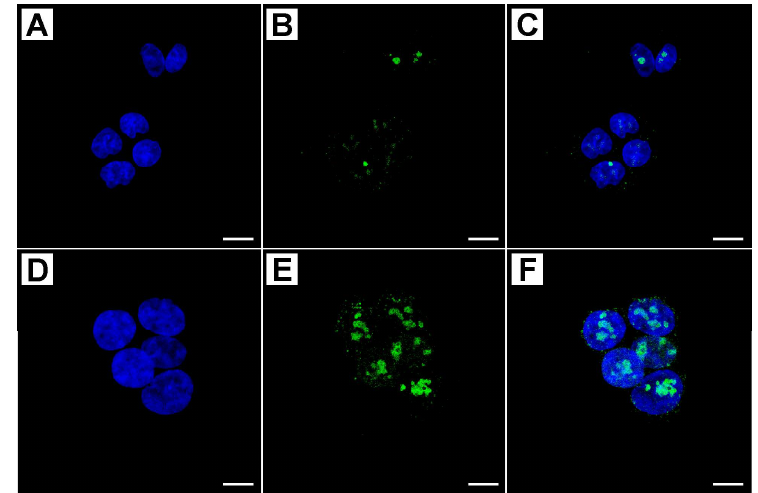
Figure 2. Confocal analysis of Ki-67 protein in treated and untreated cells with graded concentrations of metformin (blue: DAPI; Green: Ki-67; ( C , F ): merge). Cells that were treated with 10 mM MET for 48 h showed a weak immunostaining at the nuclear level ( A – C ), whereas untreated cells resulted very marked ( D – F ). Scale bar = 8 µm.